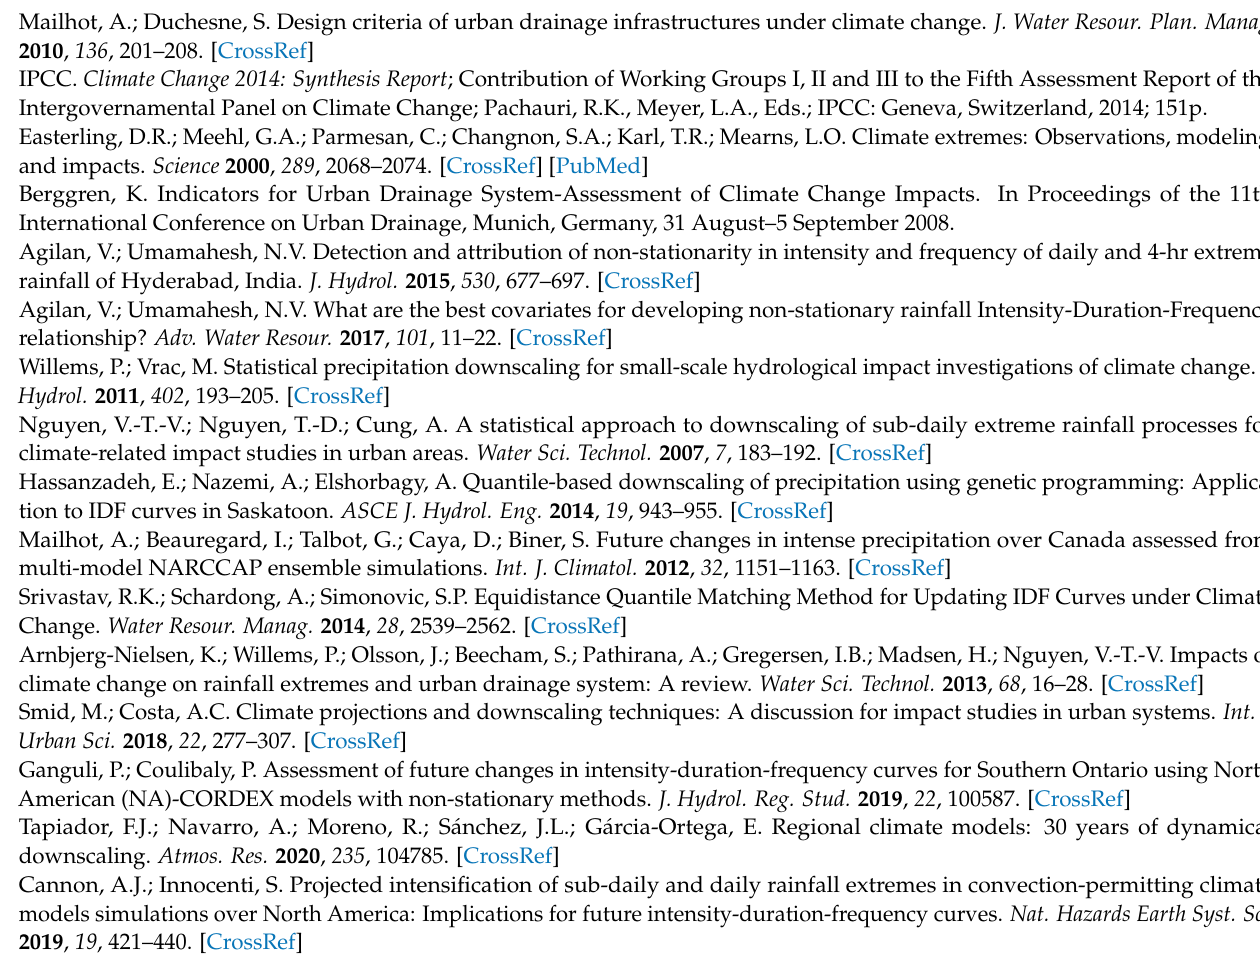
station, Table S5: Rainfall intensities, in mm/h, estimated for the multimodel ensemble for the Moncton station, Table S6: Rainfall intensities, in mm/h, estimated for the multimodel ensemble for the Shearwater